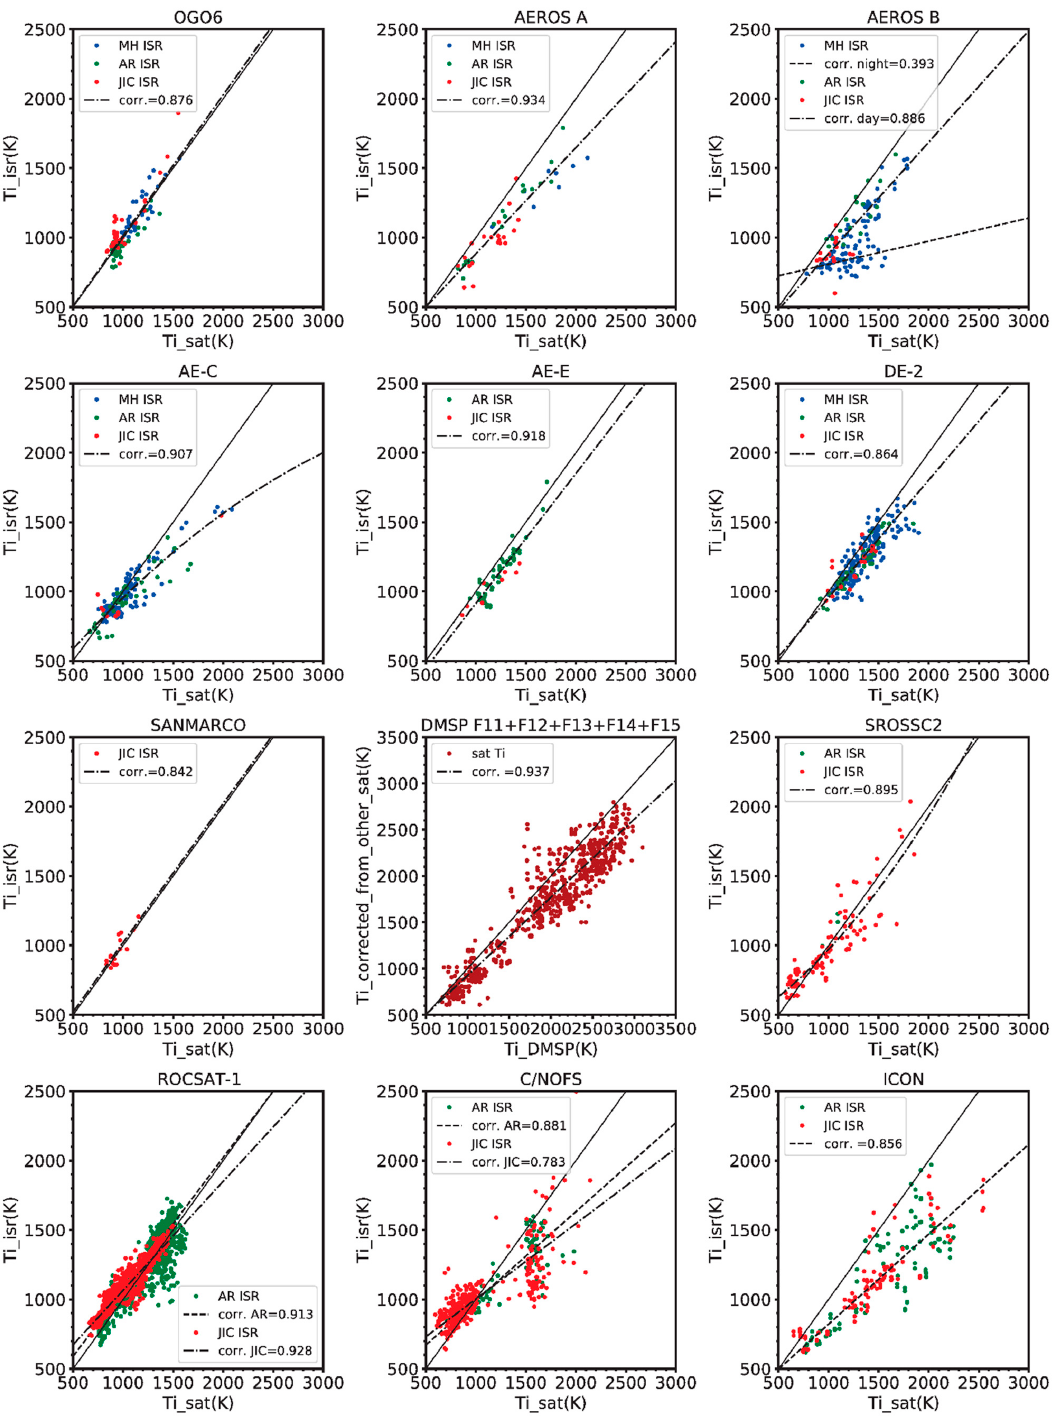
Figure 2. Scatterplots of binned Ti values from ISRs vs. binned Ti values from satellites. The bins corresponding to Jicamarca are shown by red points, Arecibo by green points, and Millstone Hill by blue points. Information on the Pearson correlation coefficient (corr.) is also included. For DMSP (brown points), the scatterplot represents a comparison with already corrected satellite data (vertical axis; “other_sat” stand for DE-2, OGO-6, and C/NOFS). Additionally, shown are the least-square fits to the data (dash-dotted and dashed line) and the line marking perfect agreement: Ti_sat = Ti_isr (solid